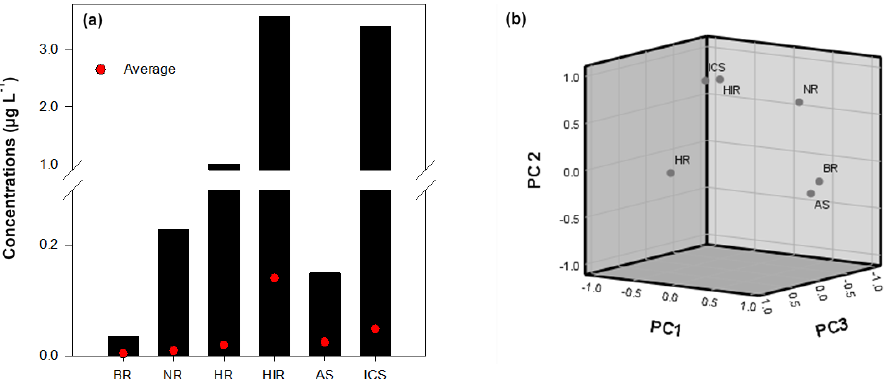
Figure 4. ( a ) Cumulative concentrations of VOCs at different sampling sites, and ( b ) loading plot of principal component analysis (PCA) analysis. BR: Bukhan River, NR: Namhan River, HR: